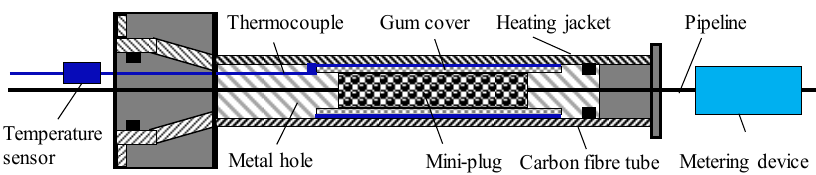
Figure 1. Carbon fiber holder for high-pressure, high-temperature online flooding.